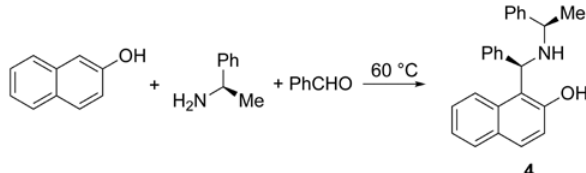
Scheme 6. Reaction between 2-naphtol, arylaldehydes and (R)–phe-